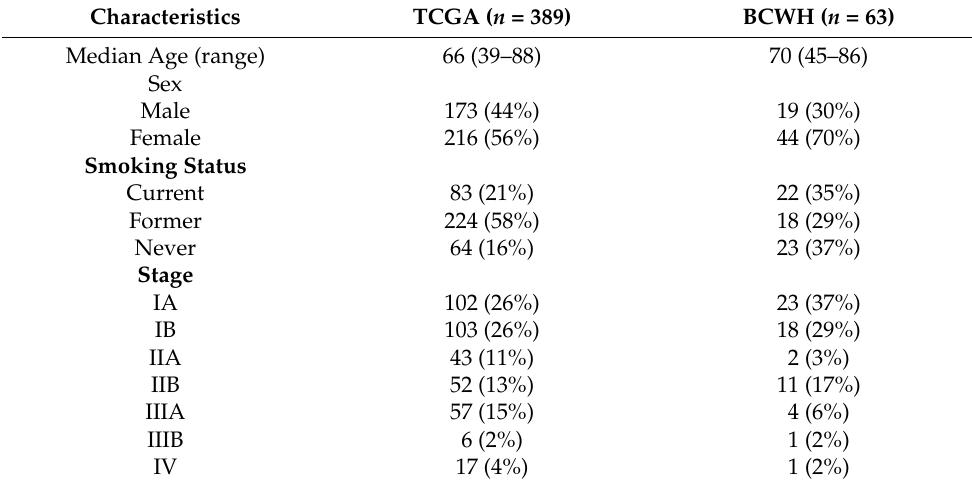
Table 1. Clinical information for LUAD patients within the TCGA and BCWH